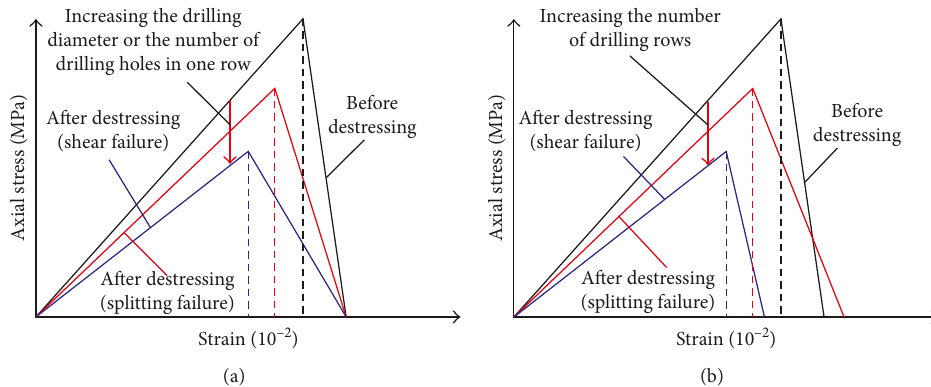
Figure 12: Sketch of the influencing mechanism of drilling arrangement on the prevention mechanism of destress drilling method. (a) Different drilling diameters and numbers of drilling holes in one row. (b) Different numbers of drilling